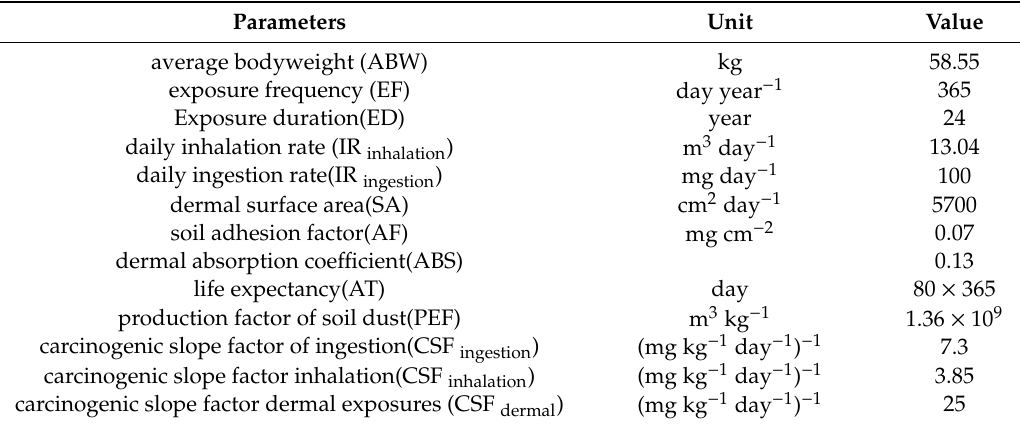
Table 2. Parameters used in the incremental lifetime carcinogenic risk assessment.